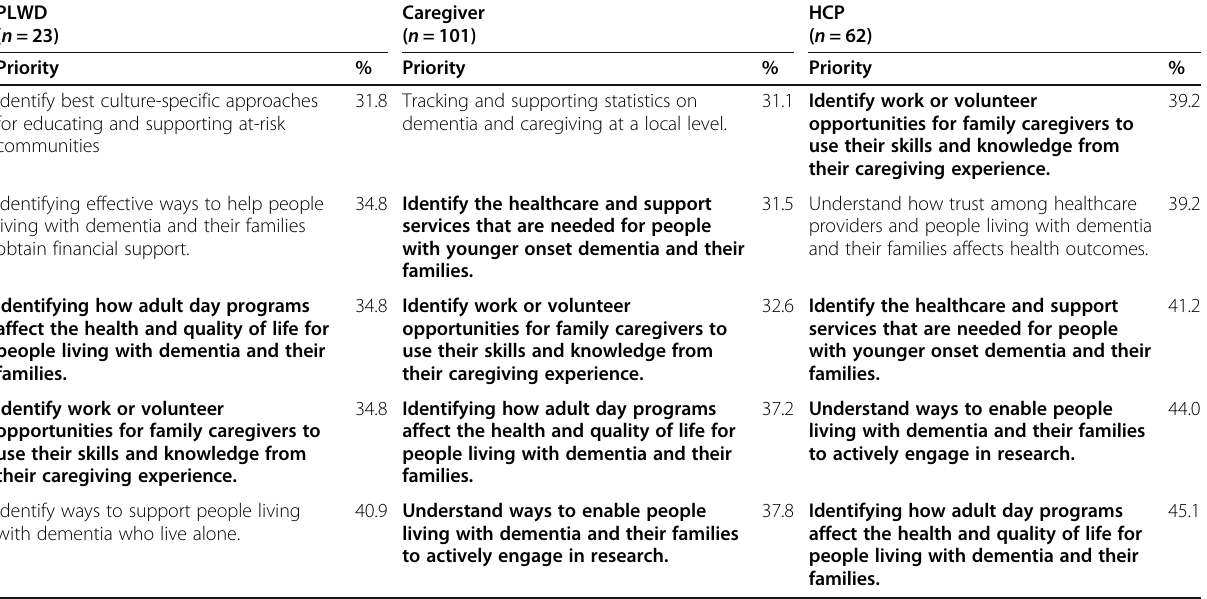
Table 3 Bottom 5 “ Very Important ” Priorities by Stakeholder Group